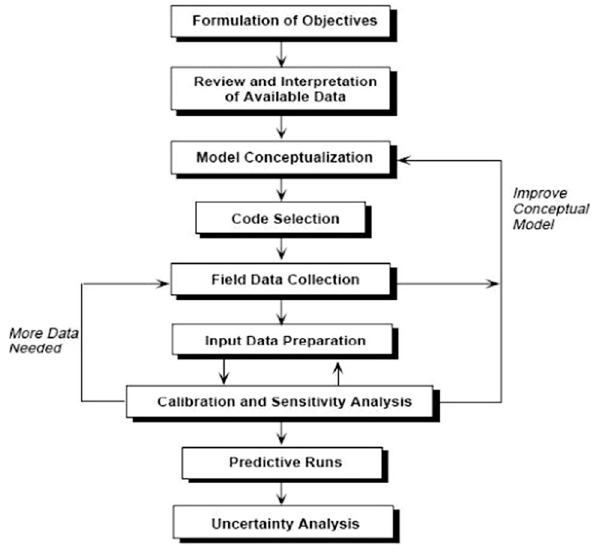
Fig. 4 Flow chart of